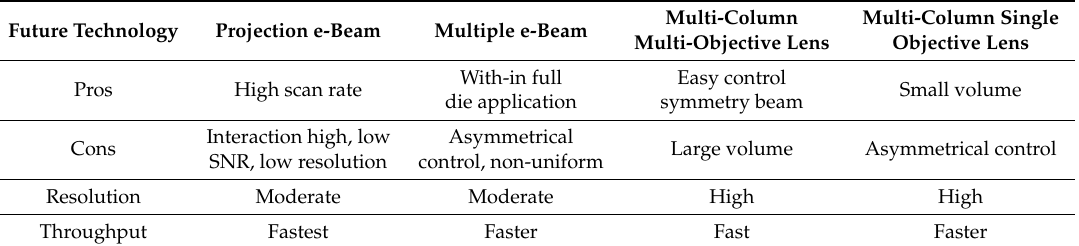
Table 3. Comparison of